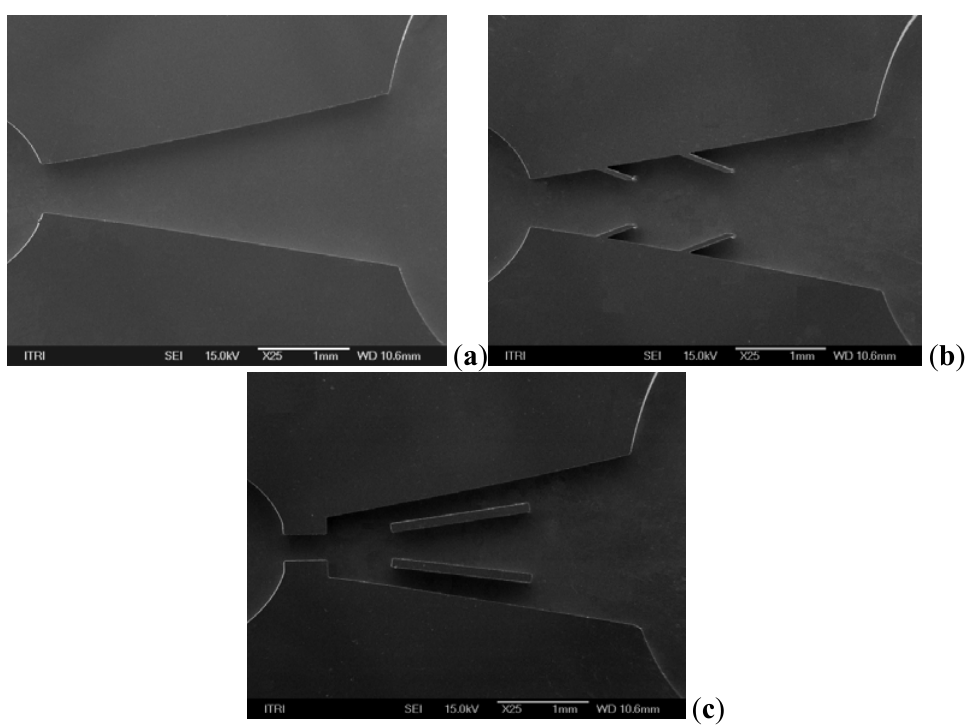
Figure 6. The SEM photo of obstacle tested